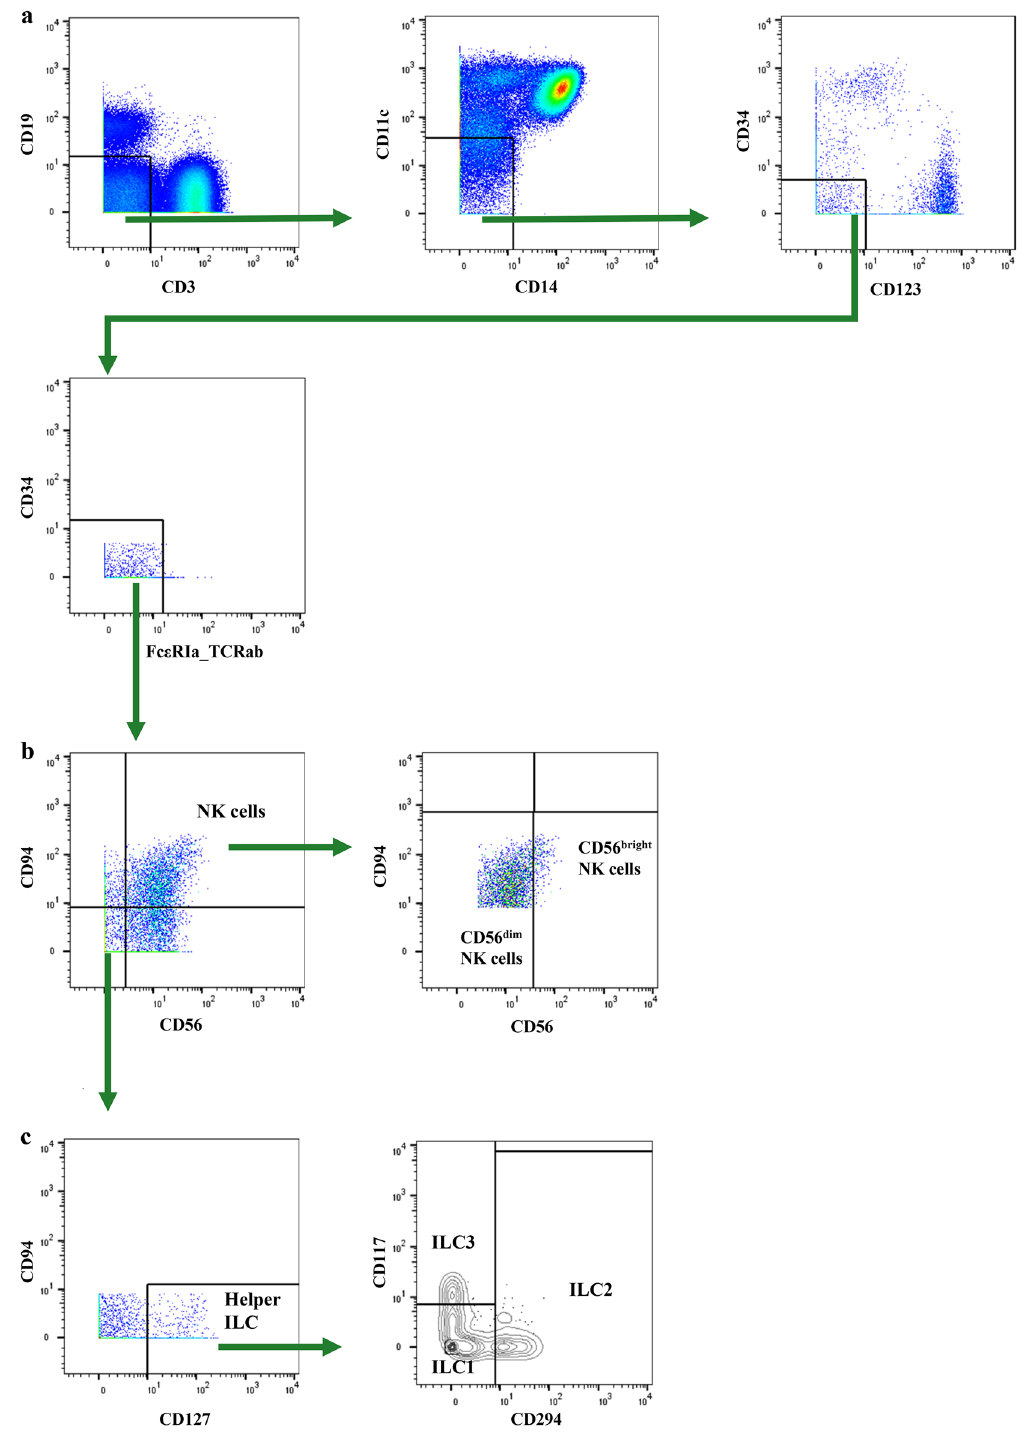
Figure 1. Gating strategy on CD45+ live PBMC to identify ILC subtypes. ( a ) Biaxial gating for Lin−(CD3− CD19−CD14−CD11c−CD123−CD34−FcεRIa−TCRab−) live CD45+ PBMC (peripheral blood mononuclear cells). ( b ) Natural killer (NK) cells were defined as Lin-CD56+CD94+ and subdivided into CD56dim and CD56bright NK cells. ( c ) Helper ILC were defined as Lin−CD56−CD94−CD127+ and subdivided into innate lymphoid cell (ILC) type 1 (CD294−CD117−), ILC2 (CD294+CD117+/−) and ILC3